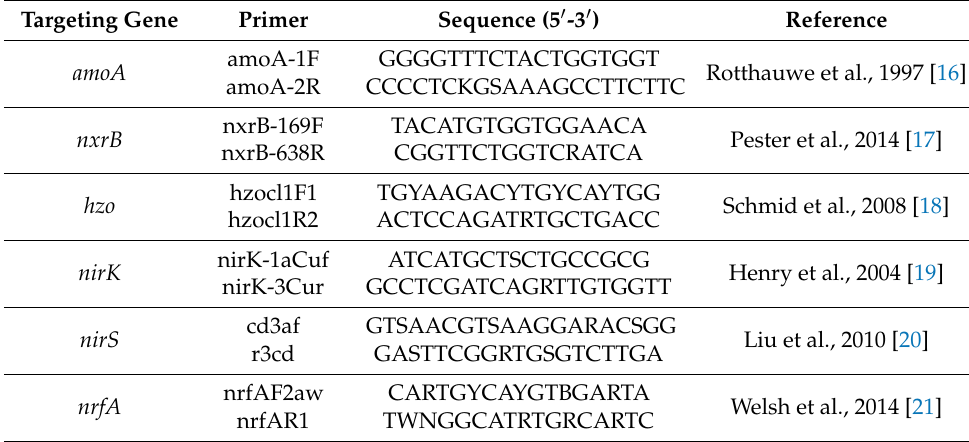
Table 3. List of the primers for